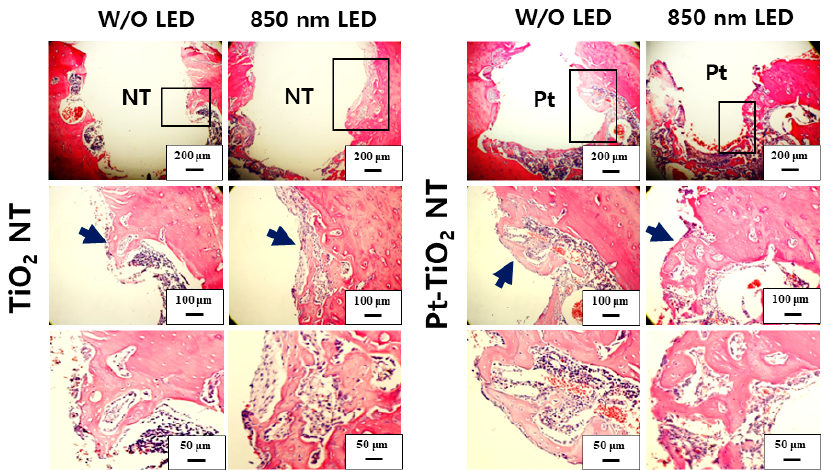
Figure 10. H&E-stained images of the tissues around the TiO 2 NT- and Pt-TiO 2 NT-treated implants after two weeks.